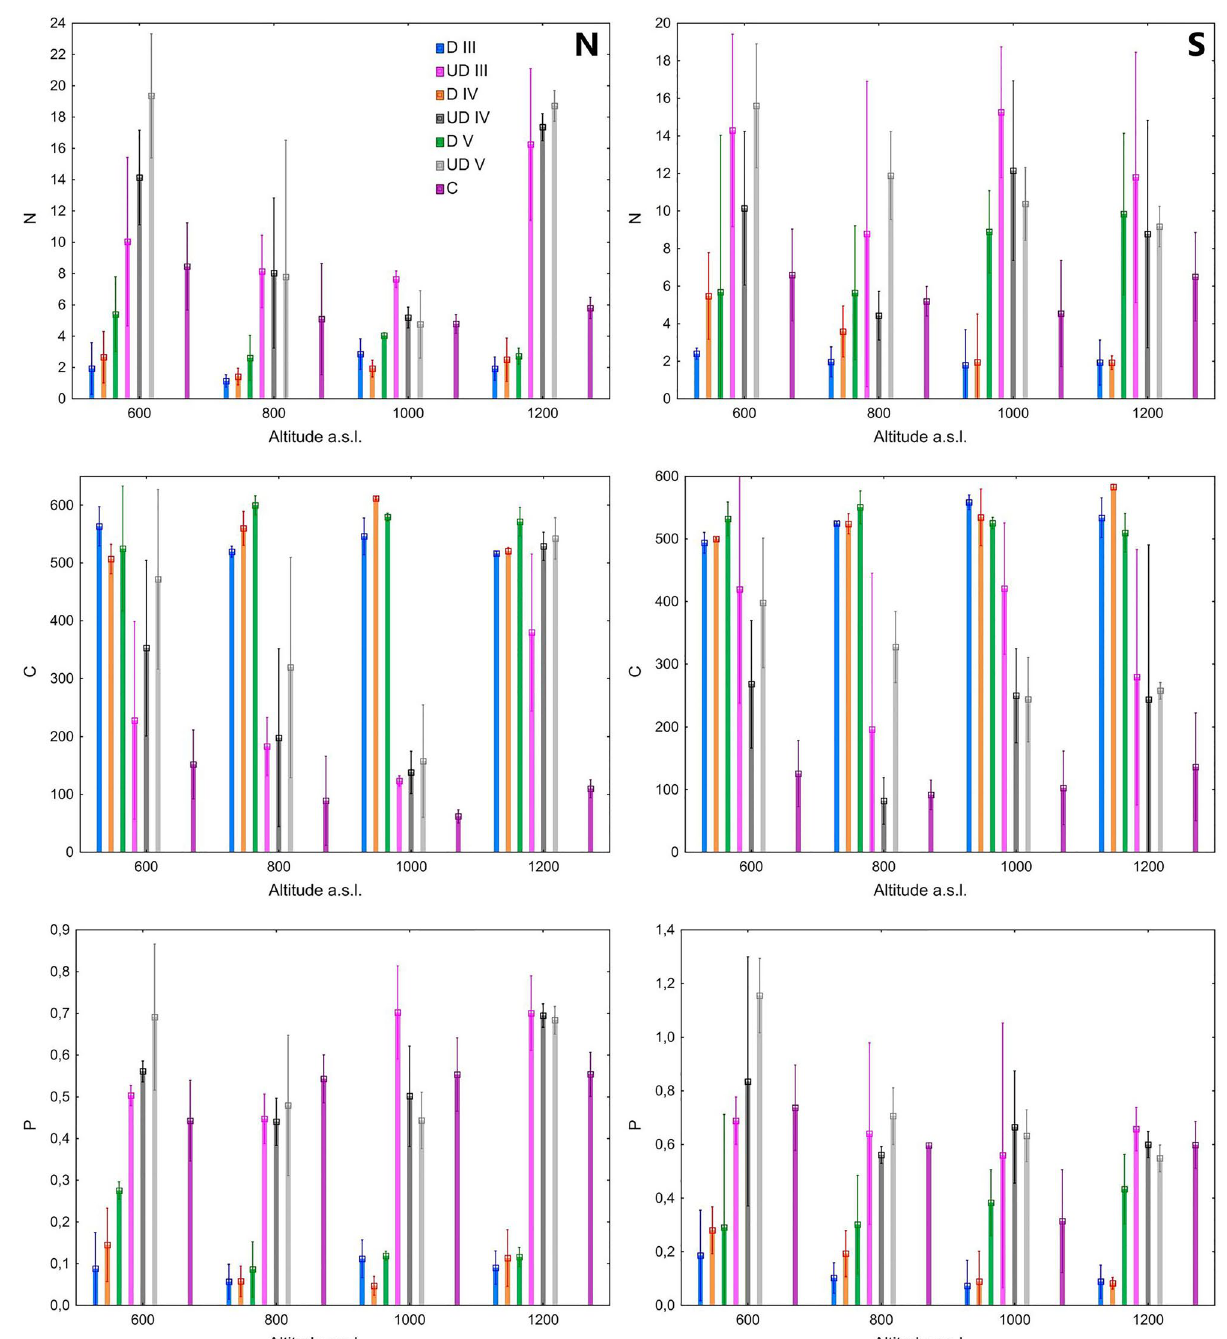
Figure 1. Content of N (g kg -1 ), C (g kg -1 ) and P (g kg -1 ) in wood (D) and soil samples ( UD soil samples under deadwood; C control soil) in relation to exposure, altitude and decay clases (III, IV and